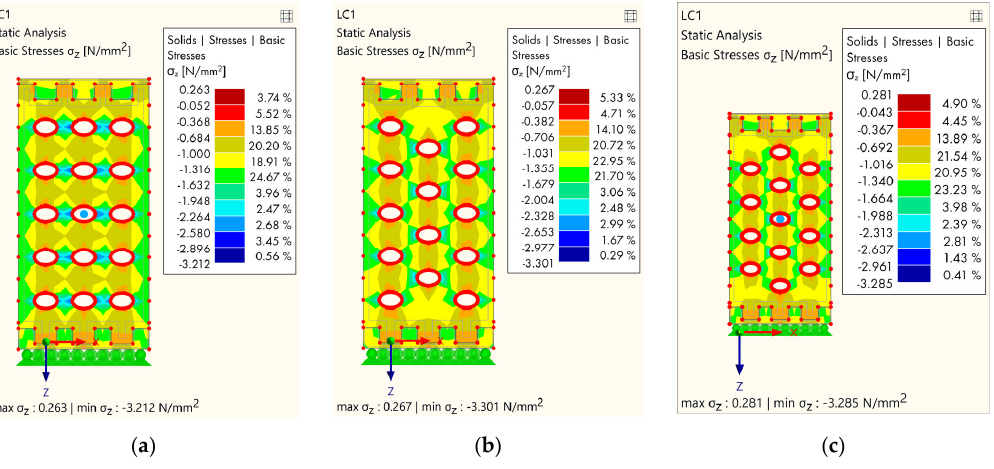
Figure 13. Results of FEM analysis—stress: ( a ) Each subsequent lamella without cavities; ( b ) alternating arrangement of holes, type 1; ( c ) alternating arrangement of holes, type 2. The third group of models (Figure 14) is shown in the variation of the columns of cavities.